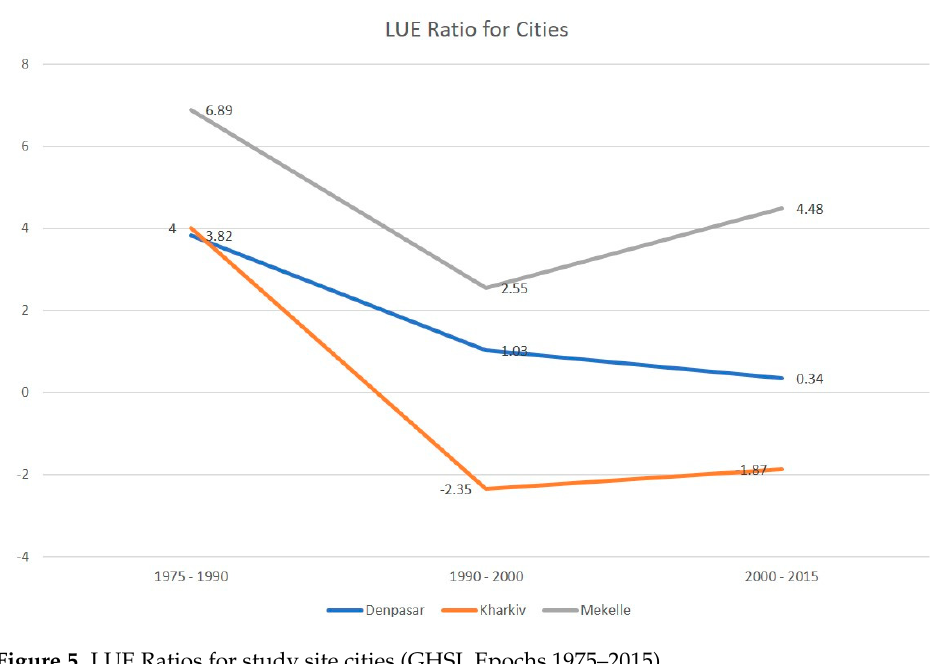
Figure 5. LUE Ratios for study site cities (GHSL Epochs 1975–2015). Table 5. Changes in population and land consumption.